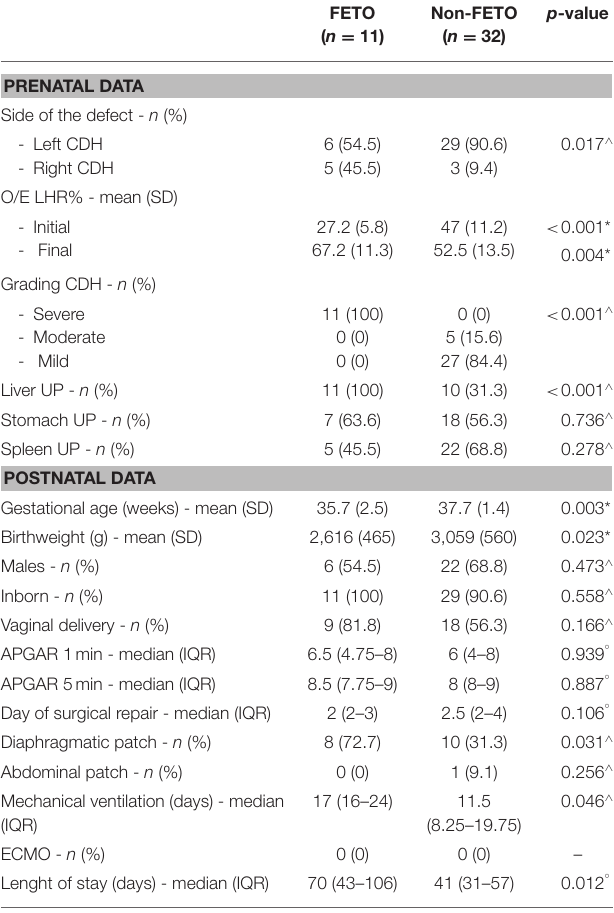
TABLE 3 | Comparison of the characteristics between FETO and non-FETO